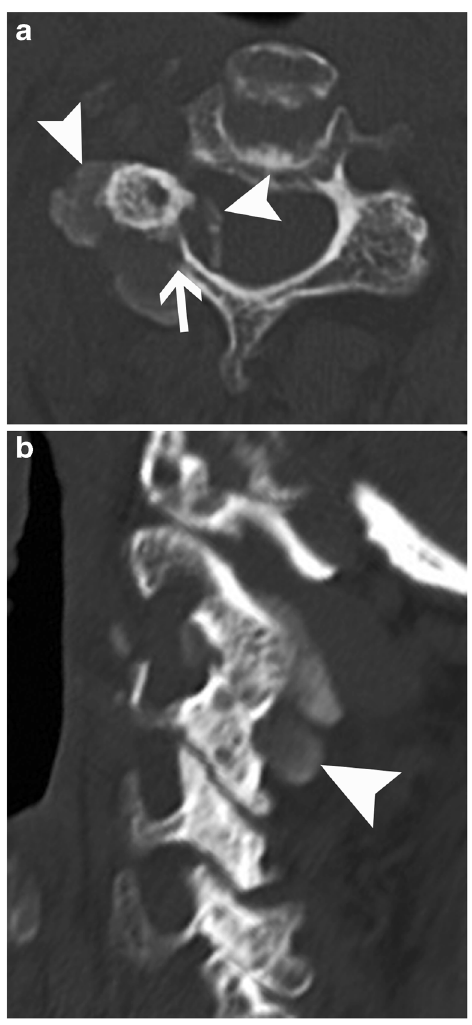
Fig. 15 Cervical facet joint calcifications. ( a ) Axial and ( b ) sagittal CT images ofthe cervical spineshowdense material (arrowheads) in the right C2 – C3 facet joint. Note the associated bone erosion of the right lamina (arrow)